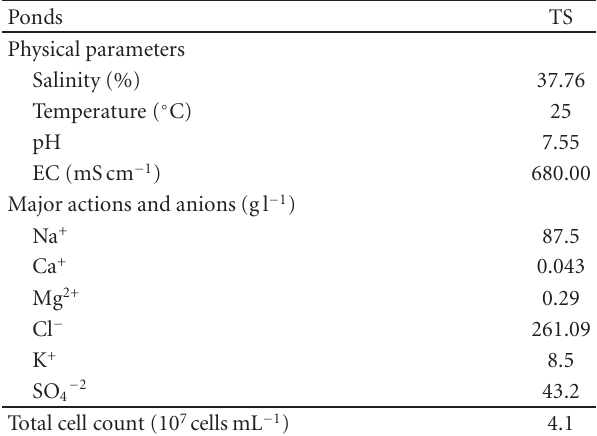
Figure 3: E ff ect of NaCl concentration on growth rate of strain ETD6 cultivated in the medium DSC-97. Cultures were incubated at 37 ◦ C. Experiments were repeated at least three times, and the standard deviation was always below 10%. Table 1: Physicochemical characteristics of TS pond on March